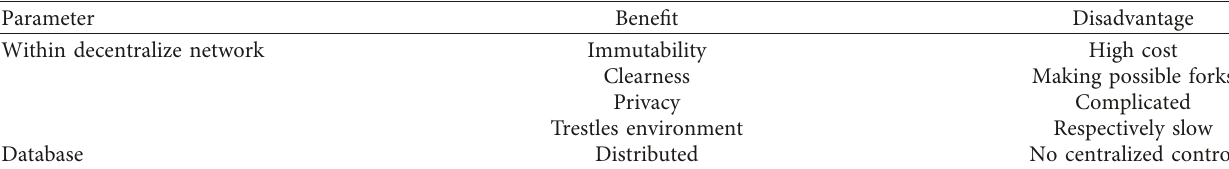
Table 2: Benefit and disadvantage of decentralized